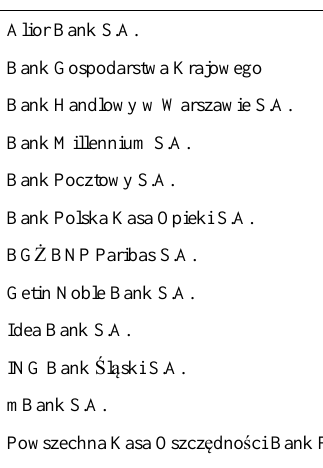
Name of the Bank (Alphabetical